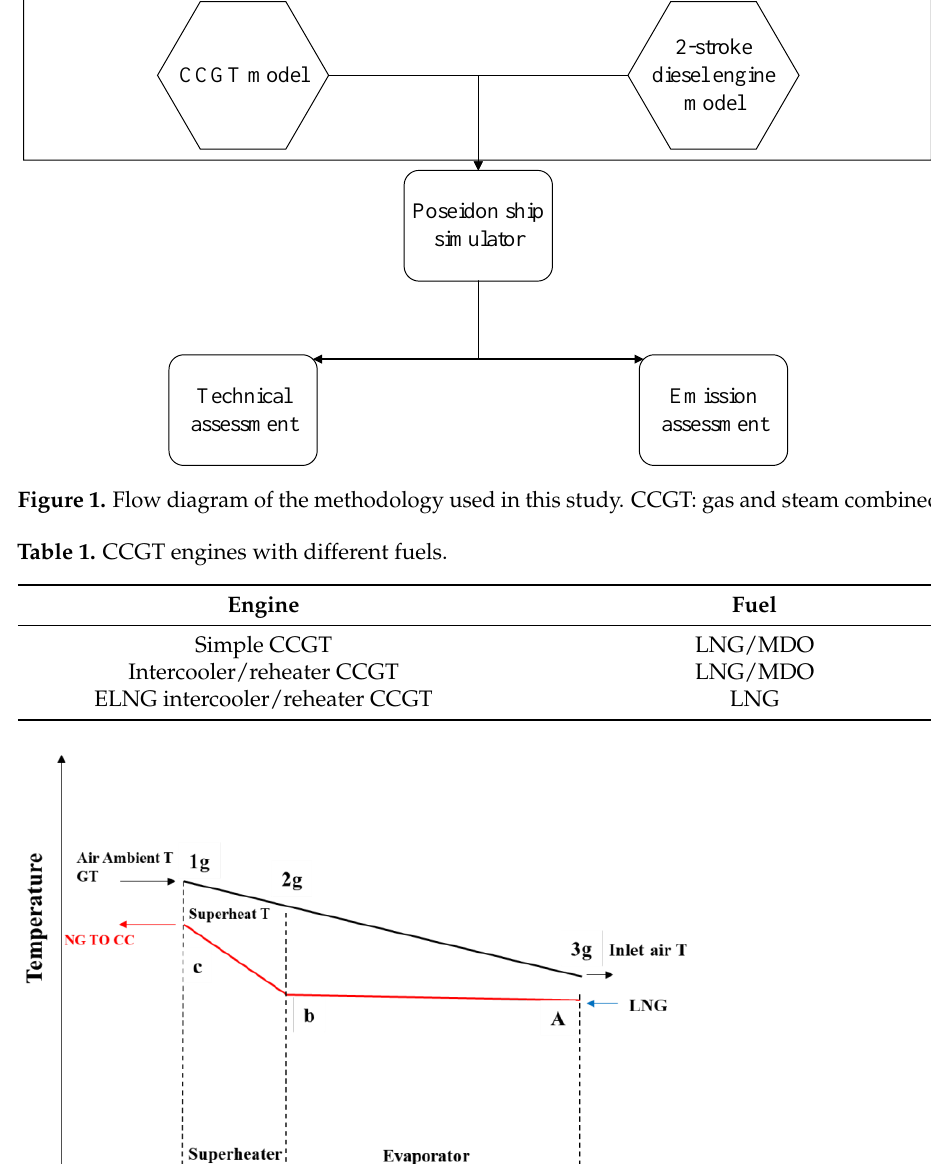
Figure 1. Flow diagram of the methodology used in this study. CCGT: gas and steam combined cycle.